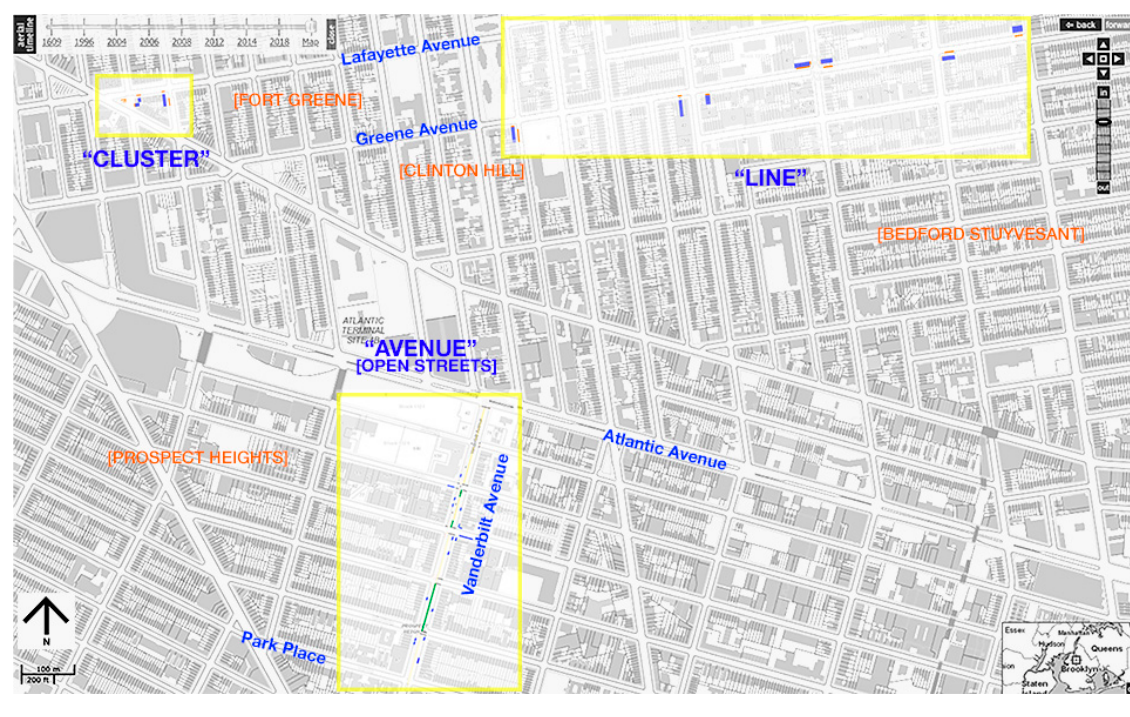
Figure 2. Case study: Cluster, Line and Avenue neighbourhood map (Source: author)